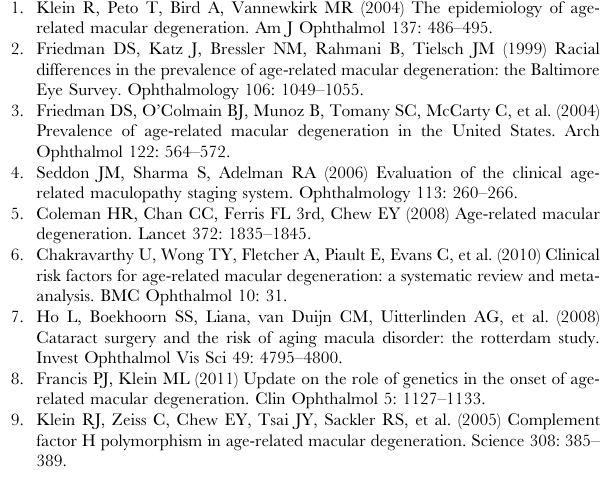
Table S1 Genotype distribution of the analyzed polymorphisms in patients and controls. (XLSX)